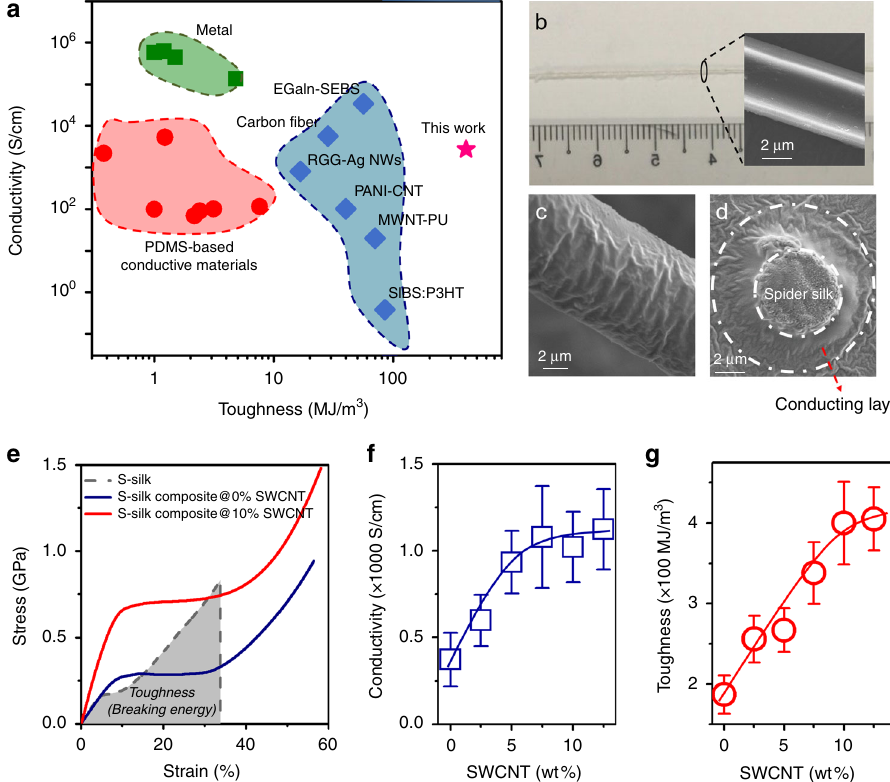
Fig. 1 Toughness and conductivity of spider silk composites. a Graph shows the conductivity and toughness of different fl exible materials. Green represents metals, red is PDMS-based stretchable conductors, and blue represents other special conducting materials/structures. Pink star represents S-silk@10% SWCNT composites described in this work. b Optical image of a bundle of raw dragline silk from Nephila pilipes . Inset shows a single silk fi ber has a very smooth surface. c SEM image showing the wrinkled surface of a single fi ber of S-silk@10% SWCNT composite formed from the intrinsic shrinkage of the spider silk after immersion in water during PEDOT:PSS and SWCNT coating. The wrinkled structure prevented any changes in the conductive path, allowing the S-silk composite to maintain its conductivity during stretching and compression. d Cross-sectional scanning electron microscopic image of a spider silk composite. The core is spider silk, and the diameter is about 3 – 4 μ m. The outer conducting layer is about 2 μ m. e Stress – strain curves of natural spider silk (S-silk), spider silk with PEDOT:PSS@0%SWCNT (S-silk composite@0%SWCNT), spider silk with PEDOT:PSS@10%SWCNT (S-silk composite@10%SWCNT). Area under gray dotted curve represents toughness of S-silk. Toughness is de fi ned as the energy needed to break the silk. f , g Conductivity and toughness of the S-silk composite increased with increasing weight percent of SWCNT, before experiencing saturation at 12.5 wt%. The maximum conductivity and toughness achieved were 1077S/cm and 420MJ/m 3 , respectively. Our S-silk composite is more conductive and tougher than the other fl exible materials shown in Fig. 1a. The error bars in f and g show standard deviations based on 50 independent